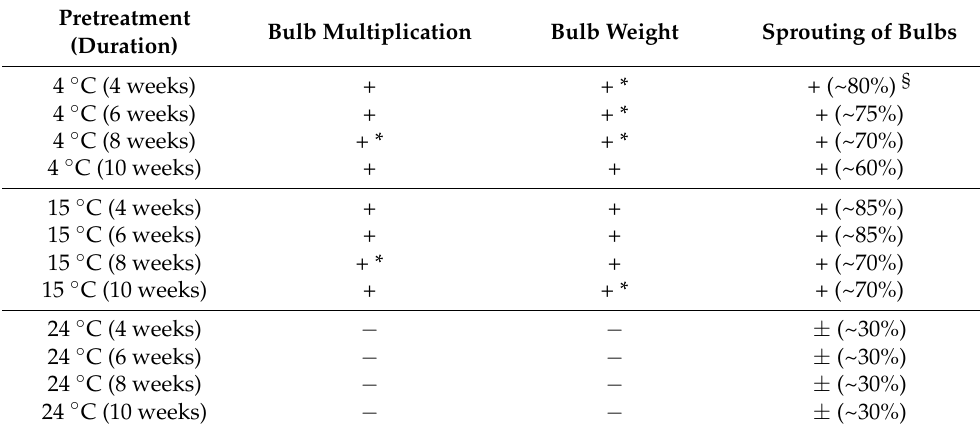
Table 2. Effect of pretreatment and its duration on F. meleagris bulb multiplication, weight and sprouting after 4 weeks of subsequent growth at 24 ◦ C